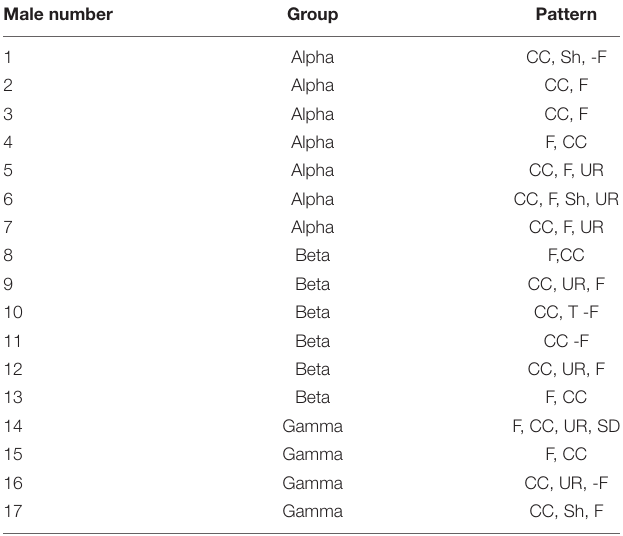
TABLE 2 | The individual profiles of emitted